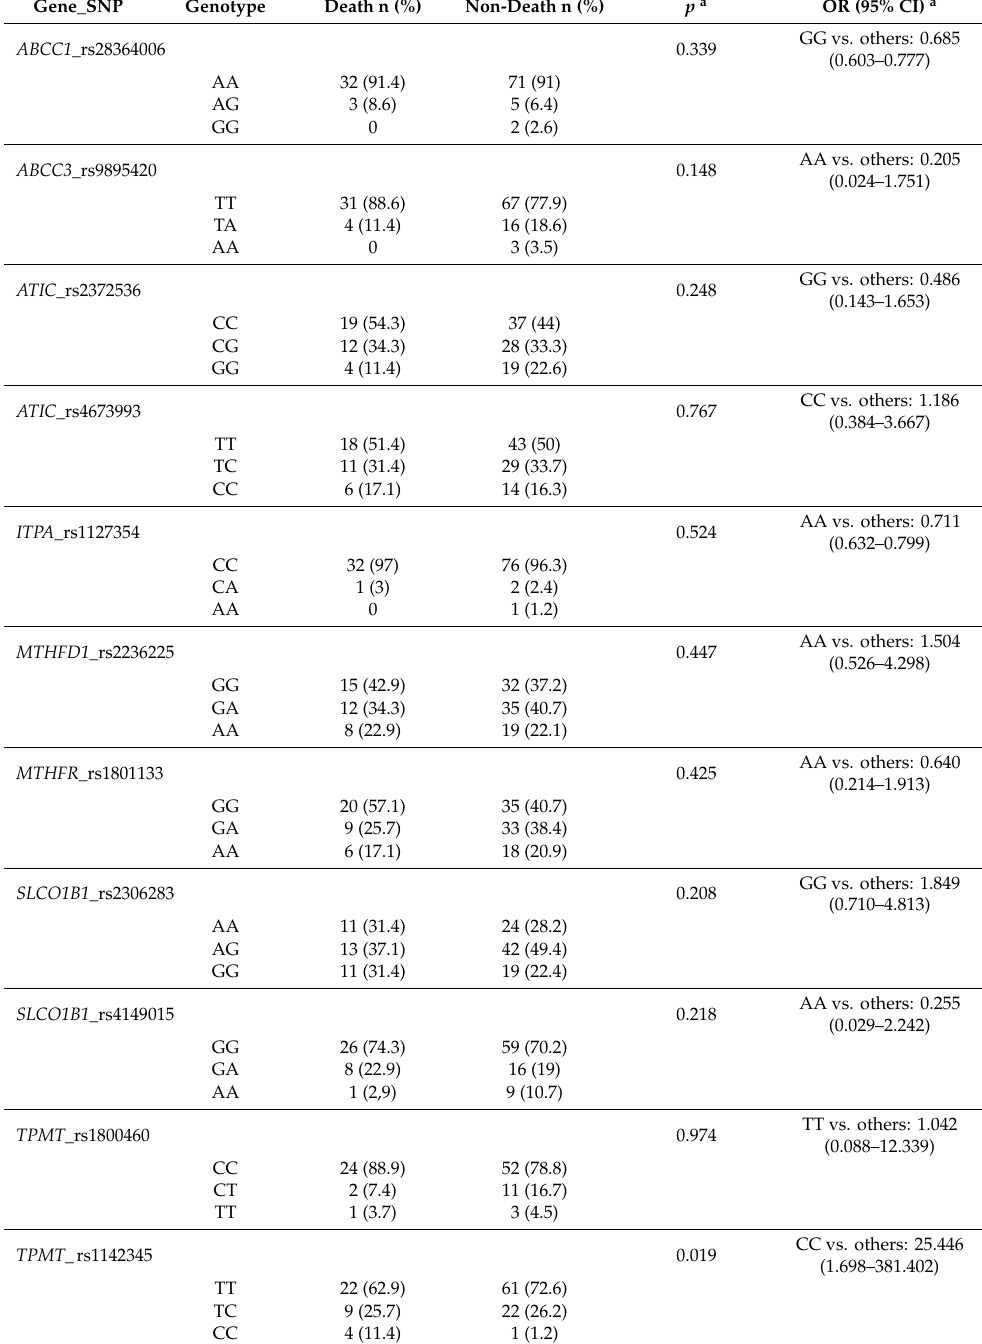
Table 4. Association analysis of selected generic variants and the incidence of death in treating ALL in